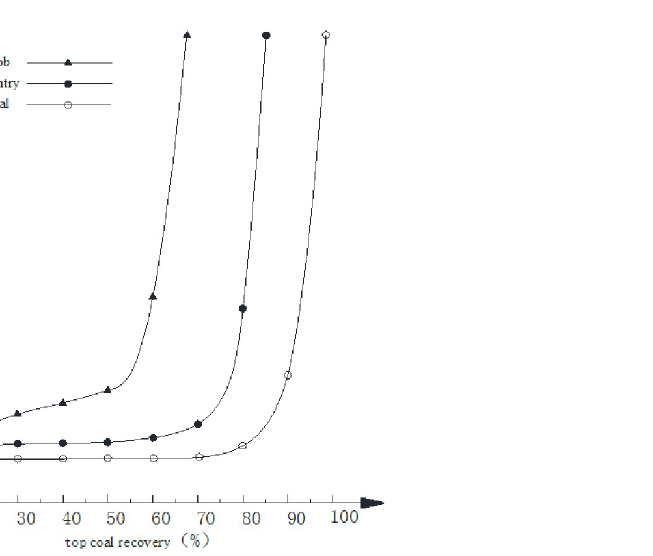
The re-mined activity in the lower seam may improve the cavibility of top coal by increasing the degree of fragmentation of the upper seam and waste rocks. The caving materials above the shield window can be assumed as the viscous fluid. The caving process is simplified and analysed as the problem of unsteady flow at the thin walled nozzle. The unsteady flow model of the caving materials at the shield caving window is shown in Fig 9.